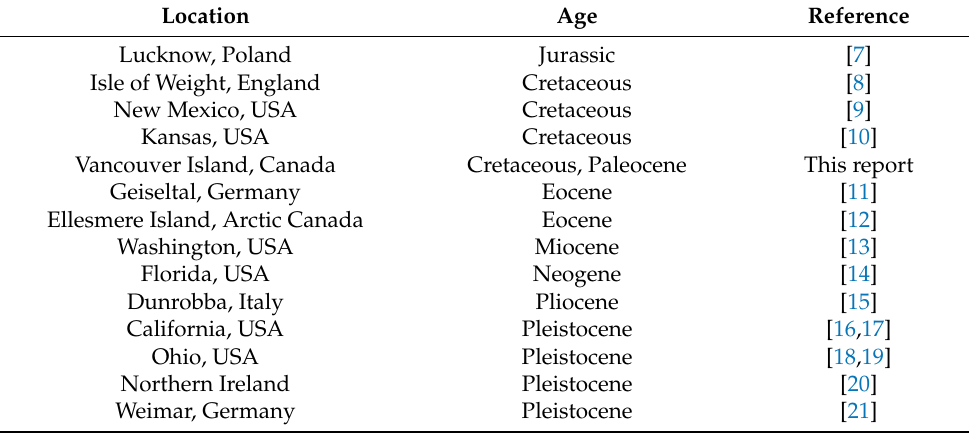
Table 1. World-wide occurrences of woods mineralized with calcium